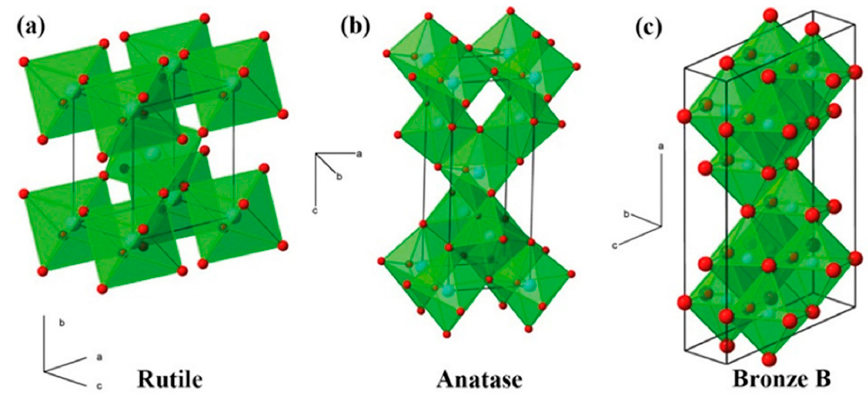
Figure 5. Polyhedral view of ( a ) rutile, ( b ) anatase, and ( c ) bronze B TiO 2 (Reproduced with permission